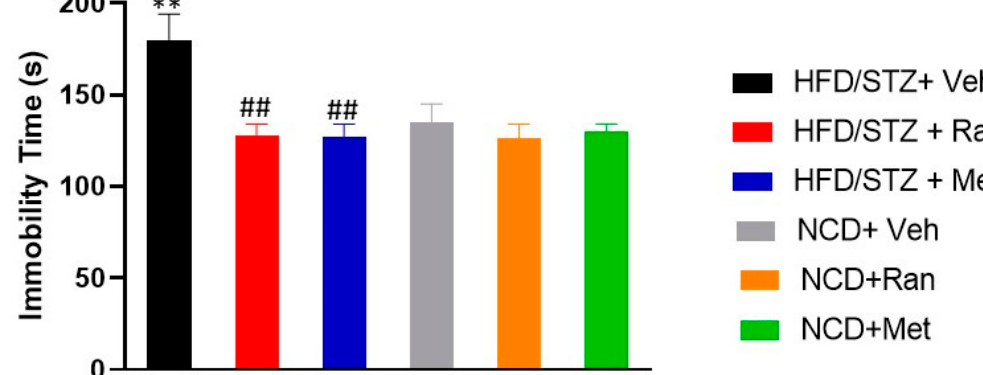
Figure 7. Forced swimming test (FST). Bars indicate the immobility time (s). Data values are means + SEM. ** p < 0.01 significantly different from NCD/STZ vehicle group. ## p < 0.01 significantly different